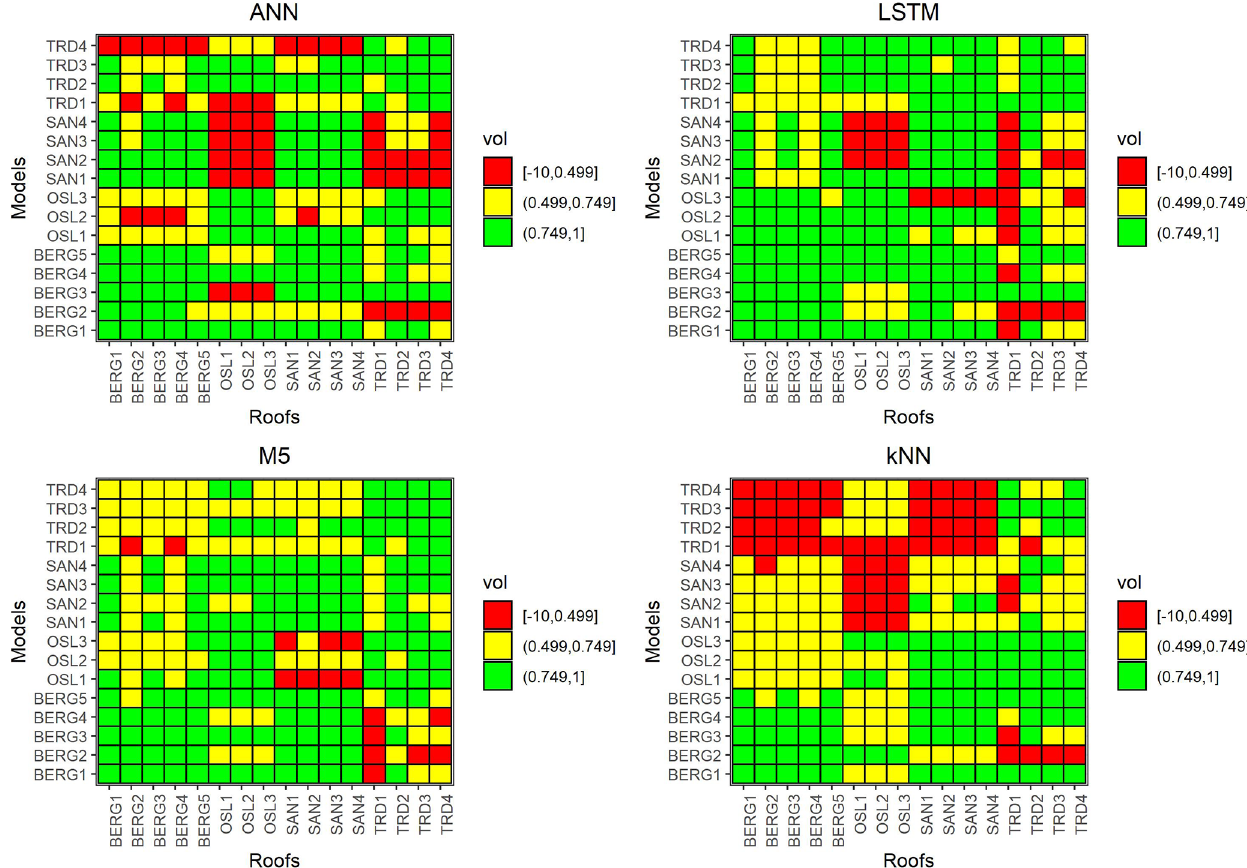
Figure 11. Transferability between the different roofs (vol). Models on the y axis are used to simulate the measured green roofs on the x